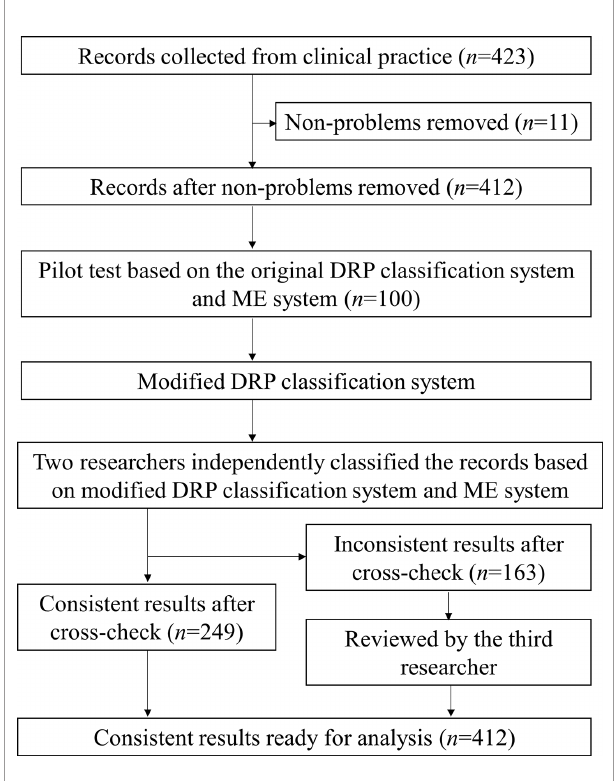
FIGURE 1 | The fl owchart for drug-related problems classi fi cation during pharmacy intervention. A fl owchart was used to show the process of DRP classi fi cation using modi fi ed DRP classi fi cation system. Records removed ( n = 11) were recommendations related to documentations or non-clinical